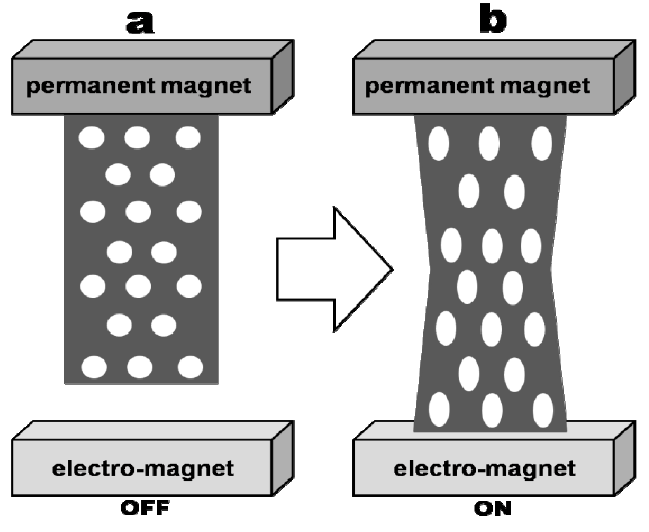
Figure 7. Schematic of a muscle-like Co polymer nanocomposites in a magnetic